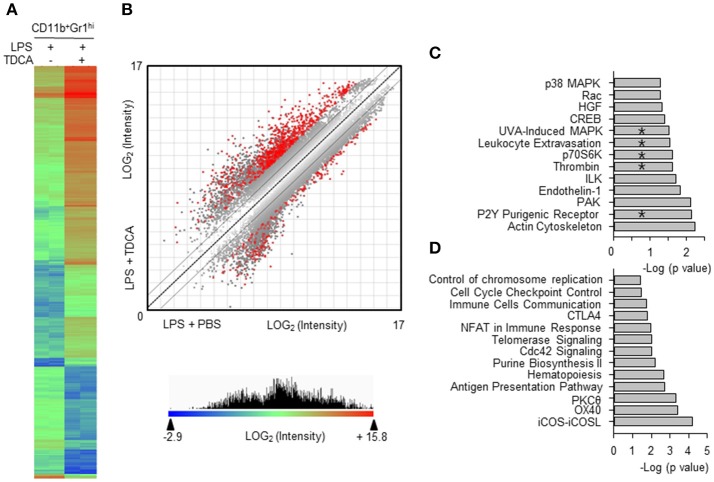
Comparison of gene expression profiles of MDSCL and MDSCLT. (A) CD11b+Gr1hi cells were FACS-purified from the LPS + PBS group (8 independent sorting, 4~9 mice samples were pooled for each sorting) and the LPS + TDCA group (5 independent sorting, 4~6 mice samples were pooled for each sorting). cDNAs from each mouse were pooled and gene expression was profiled in duplicate. Eight hundred eighteen genes were filtered (>8-fold change, p < 0.05) from 14,074 genes (p < 0.05) and analyzed to generate a heat map and scatter plot. The gene with the lowest expression value is displayed as a highly suppressed gene in blue (signal intensity = 2−2.9). The highest expression value is displayed as a highly expressed gene in red (signal intensity = 215.8). The range of expression intensity is color coded and is depicted in the right. (B) The double-log scatter plot indicates the signal intensities of all oligo probes. The 818 genes shown in red showed > 8-fold change and p-value < 0.05. The best-fit linear trend (dotted line) and the ±2-fold change lines are indicated. (C) Four hundred ninety-six genes that exhibited 5-fold down regulation (p < 0.05) were extracted, and their pathway associations were investigated. (D) Five hundred forty-four genes that exhibited 8-fold up regulation (p < 0.05) were extracted, and their pathway associations were investigated using IPA®. The pathways overlapping with the proteomic analysis are denoted by “*”. −Log (p-value) was calculated using the right-tailed Fisher's exact test to measure the likelihood that the association between a set of genes and pathway was due to random chance. Pathways with p < 0.05 are shown.